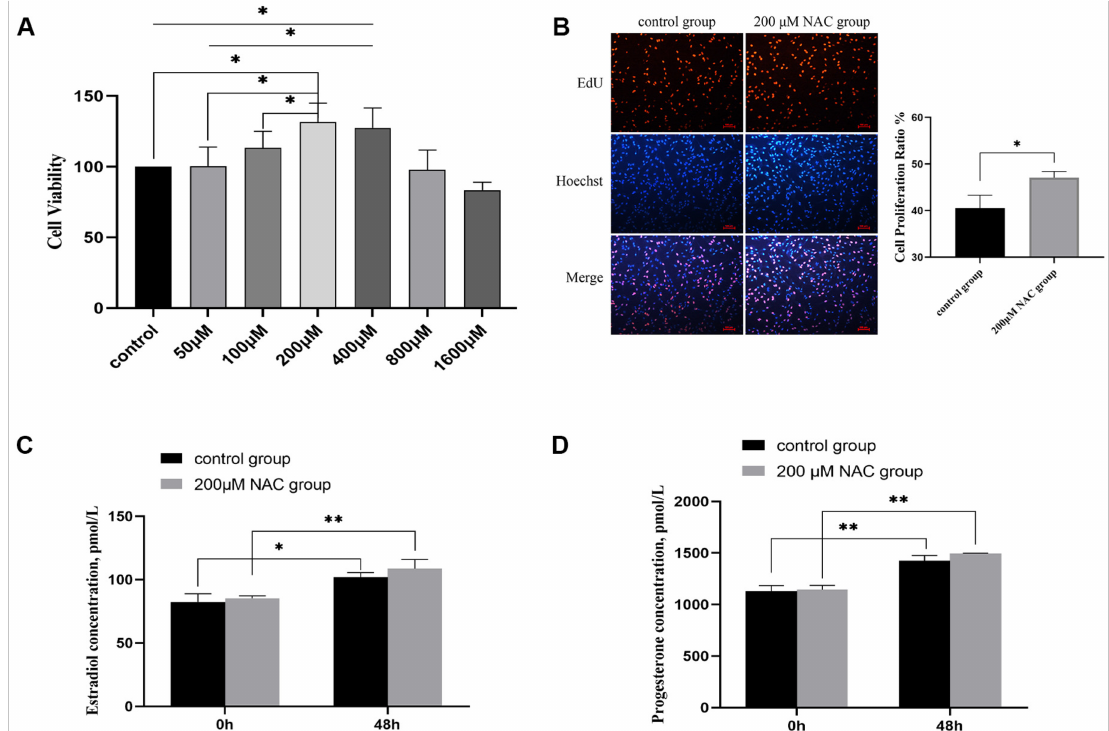
Figure 2. Regulation of NAC on the growth of granulosa cells. ( A ) Effect of different concentrations of NAC on cell proliferation. ( B ) Cell proliferation of 200 µ M NAC and control groups was detected by EdU assay at 48 h. EdU: The thymidine analog EdU in the kit replaces thymidine and infiltrates the newly synthesized DNA in the S-phase of the cell cycle. After the Click reaction, the newly synthesized DNA was labeled with red fluorescence. Hoechst: Hoechst 33342, Hoechst coloration presented light blue, round morphous, and formed fairly dark particles inside normal cell nuclei; Merge: Superimposing and merging the red fluorescence and blue fluorescence images in the same field of view. Histogram of cell proliferation ratio: The proportion of cell proliferation in the 200 µ M group was significantly higher than that in the control group. * Indicates a significant difference between the two groups at the 0.05 level. ( C ) Estradiol levels. Estrogen contents in the culture medium of the 200 µ M NAC group and control group were detected at 0 h and 48 h, respectively, n = 3. ( D ) Progesterone levels. Progesterone contents in the culture medium of the 200 µ M NAC group and control group were detected at 0 h and 48 h, respectively, n = 3. * Indicates a significant difference between the two groups at the 0.05 level. ** Indicates a significant difference between the two groups at the 0.01